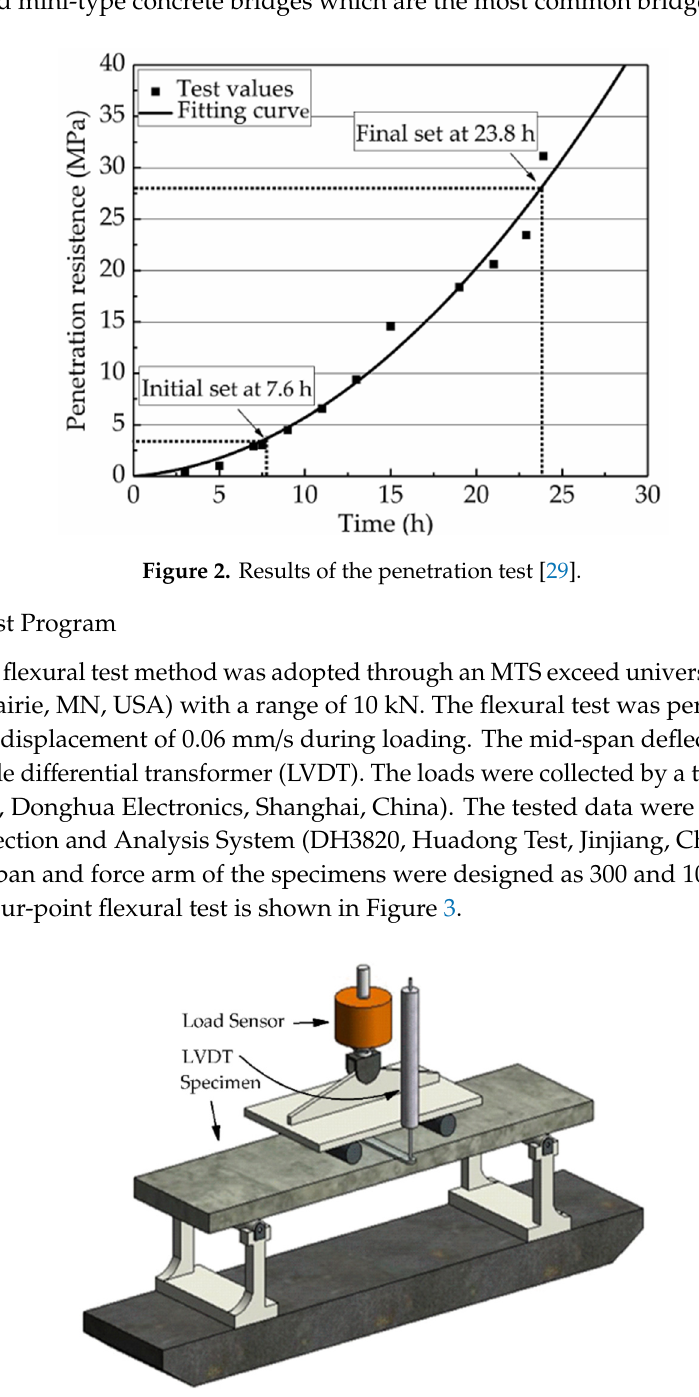
Figure 3. Sketch of the four-point flexural test.